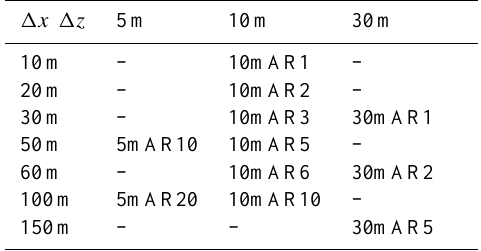
Table 3. Names of runs we performed in the control experiment. Columns and rows correspond to vertical and horizontal resolutions, respectively. The number following the character “AR” represents the grid aspect